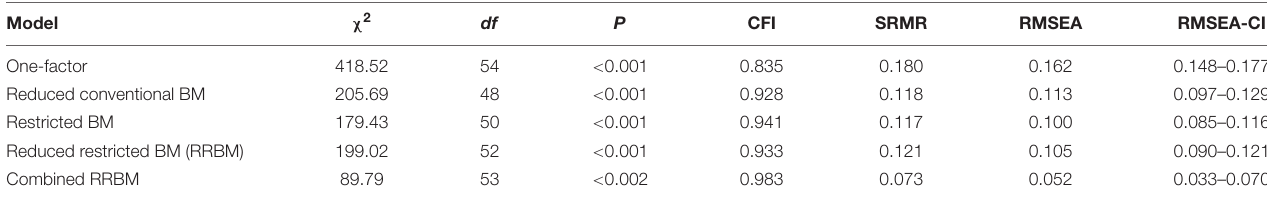
TABLE 4 | Model fit indices for the